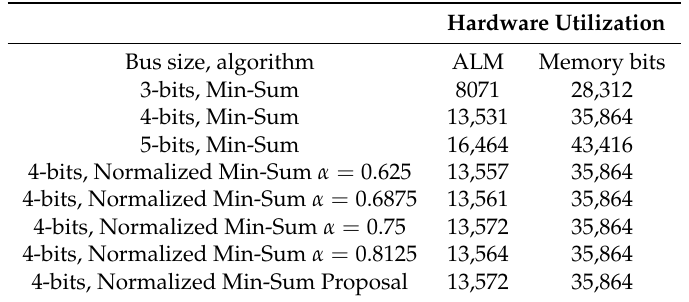
Table 1. Hardware utilization for selected versions of the QC-LDPC